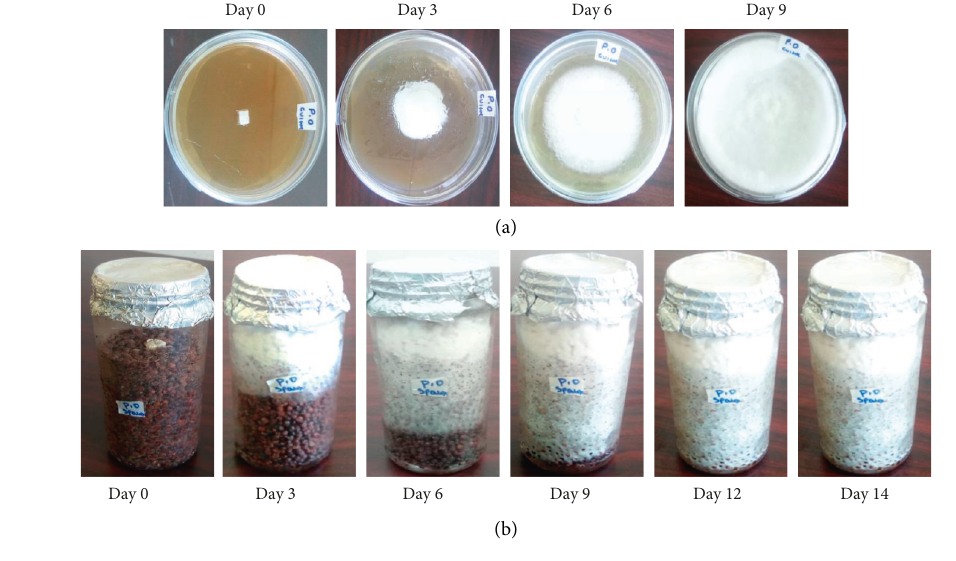
Figure 2: Mycelium growth on (a) PDA and (b) spawn.